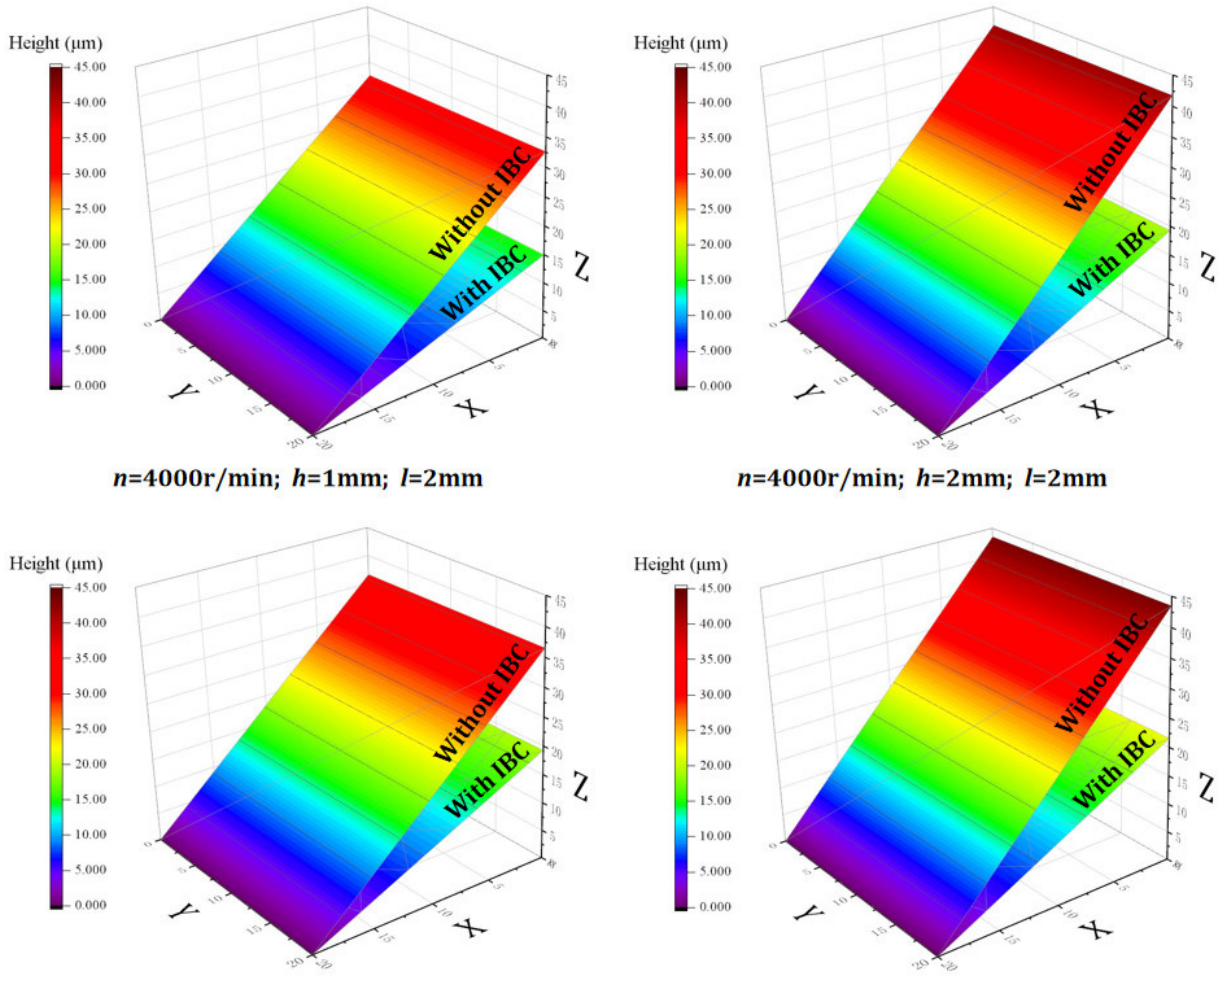
Figure 9. Comparison of average height of exit burr.